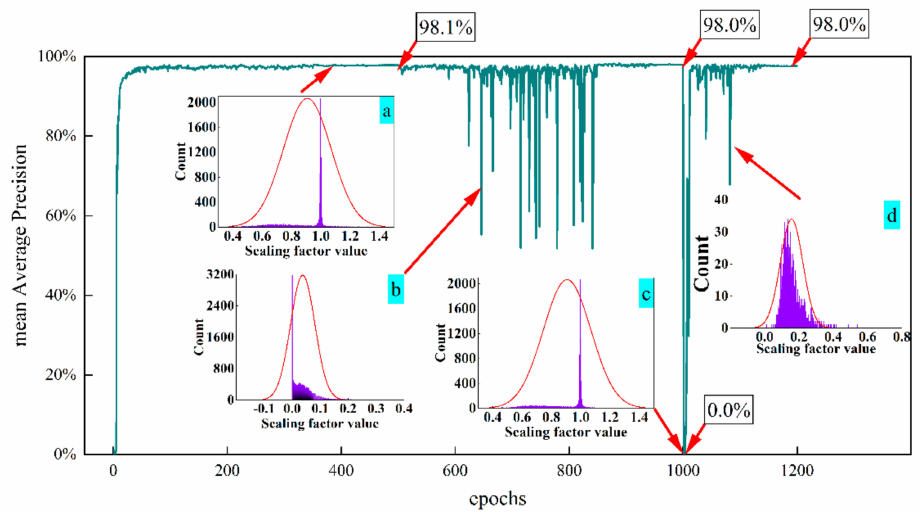
Figure 10. The mAP curve during the acquisition of ginger recognition model. ( a ) the distribution of γ -values after basic training, ( b ) the distribution of γ -values after sparse training, ( c ) the distribution of γ -values after model pruning, ( d ) the distribution of γ -values after model